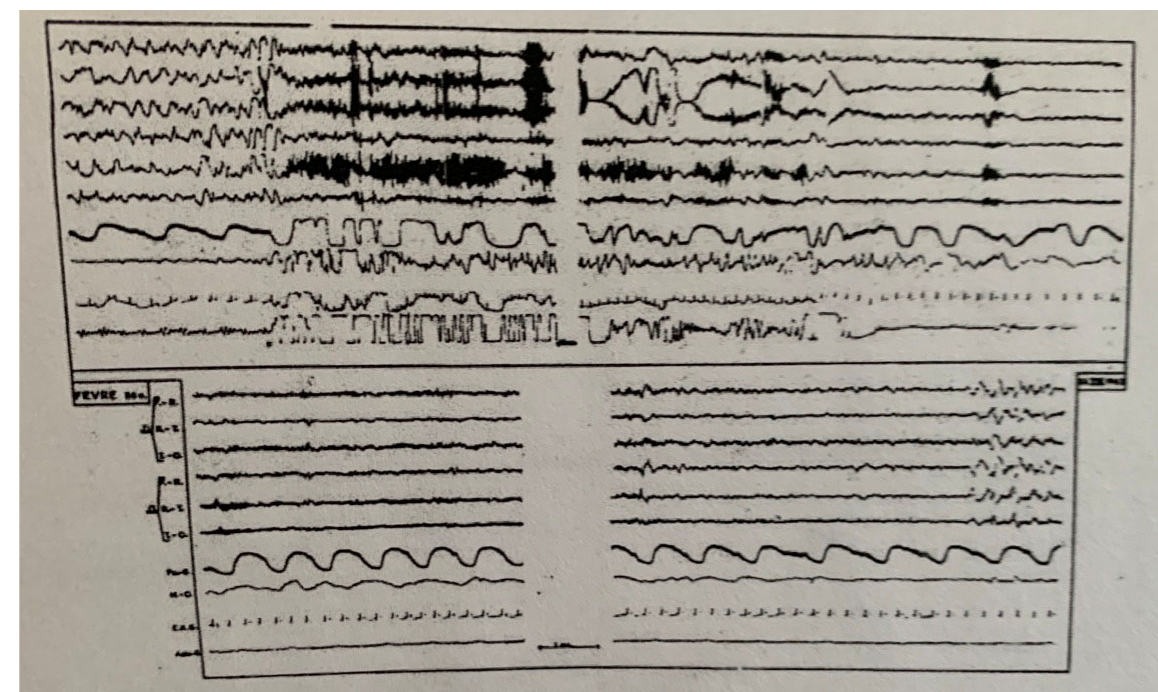
Figure 6. Sleepwalking in a 20 ‐ year old male recorded by very long electrode wires. The episode begins abruptly in stage 4 sleep (upper left segment) with movement artifacts on the actogram and intense muscle artifacts as he tries to get up. In the upper right segment, the patient gets out of bed, muscle artifacts are reduced, and the EEG has desynchronized. There is mild tachycardia. In the lower left the EEG shows stage 1 sleep patterns. In the lower right after several minutes of recording have been removed there is a transition into the onset of stage 2 sleep. Although sleepwalking historically was considered to reflect the acting out of a dream, the attacks never occur in REM sleep and are rarely associated with recall of dream-like mentation. They always begin in deep slow-wave sleep. (Adapted from Gastaut, H. and Broughton, R.: A clinical and polygraphic study of